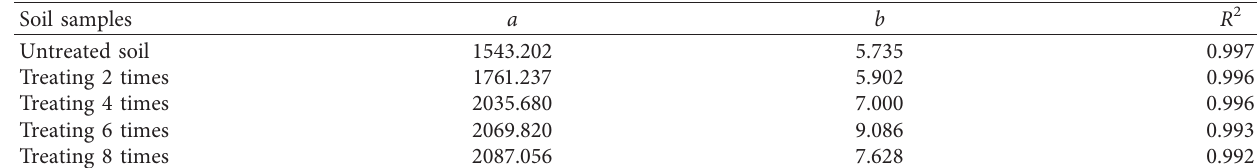
Table 4: Fitting